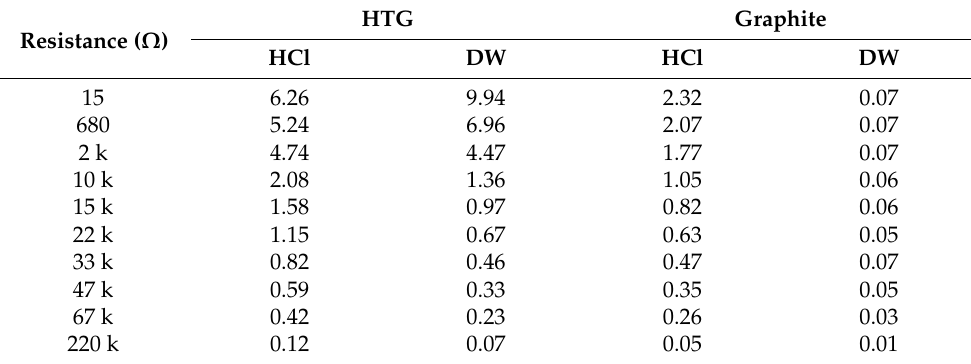
Table 1. Effect of external resistance, electrode materials, and the catholyte type on the coulombic efficiency (%) of the MFC system. HTG Graphite Resistance ( Ω ) HCl DW HCl